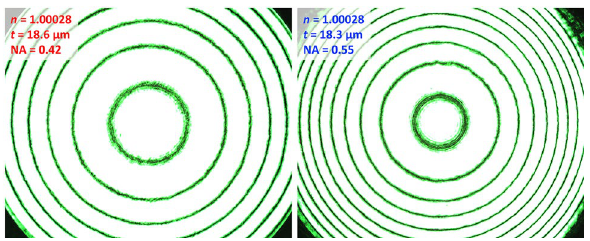
Figure 9. Comparison of ring patterns obtained from objective lenses having different numerical aperture (NA) values of (left) 0.42 and (right) 0.55. More rings can be obtained by a lens with a higher NA. The patterns are obtained from the empty DAC with an air